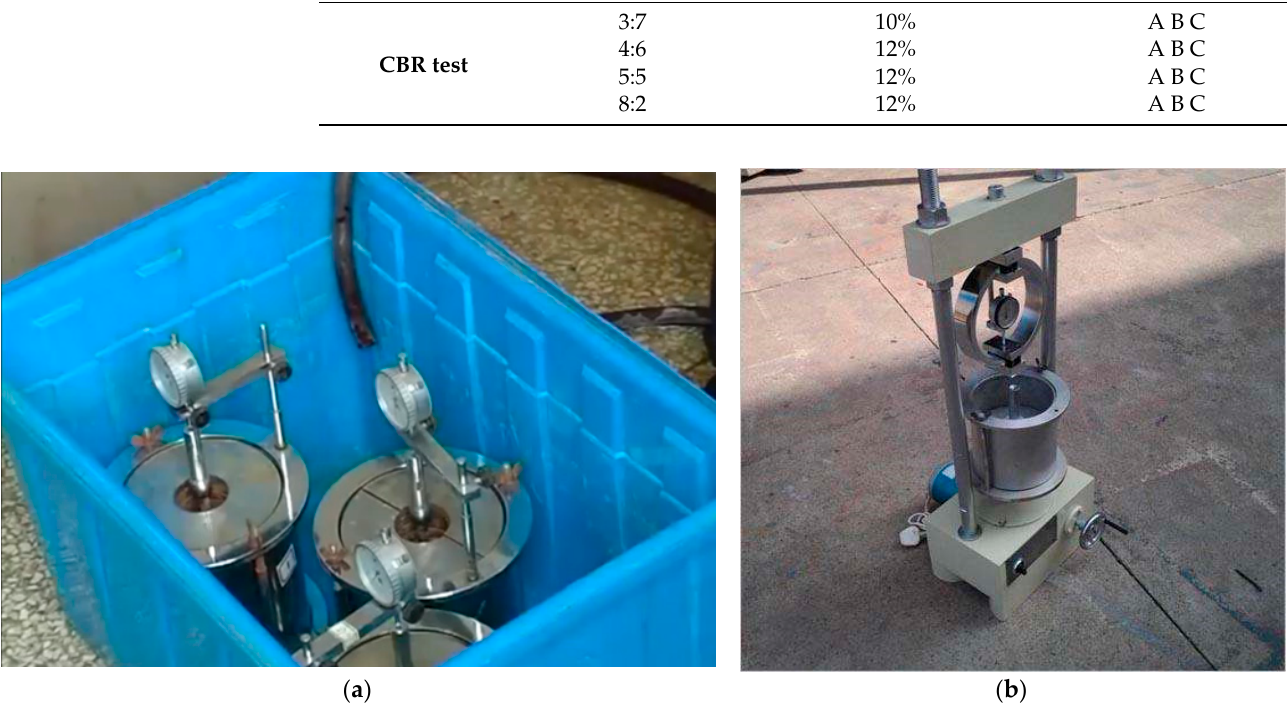
Figure 3. Load-bearing ratio test: ( a ) soak sample; ( b ) bearing ratio test equipment. Table 4. CBR test